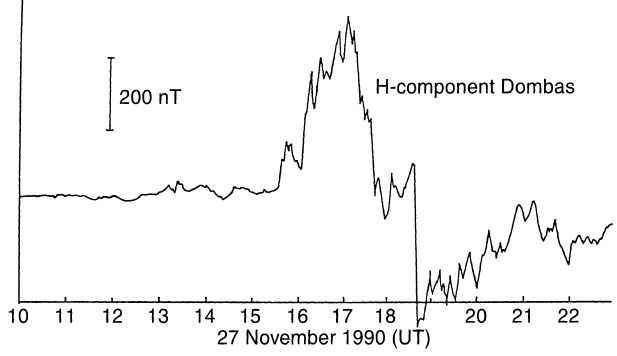
Fig. 14. H -component of Dombas at afternoon and evening on 27